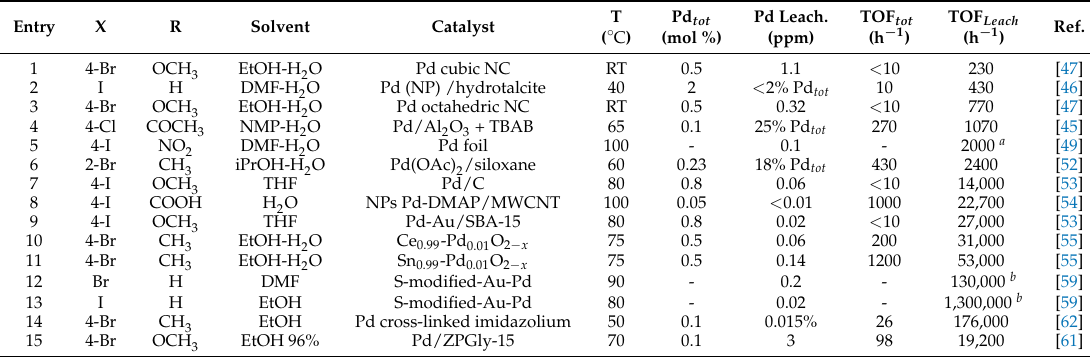
Table 2. Calculation of TOF that could be due to leached Pd from solid catalysts. a R’ = pinacol phenylboronate b R’ = 4-Cl (see Figure